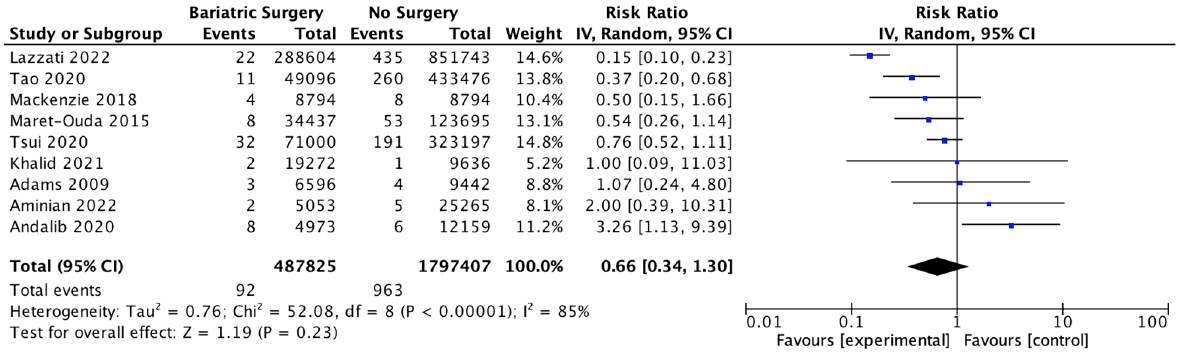
Figure 10. Oesophageal adenocarcinoma incidence [38–40,42,43,45,49,64,65].